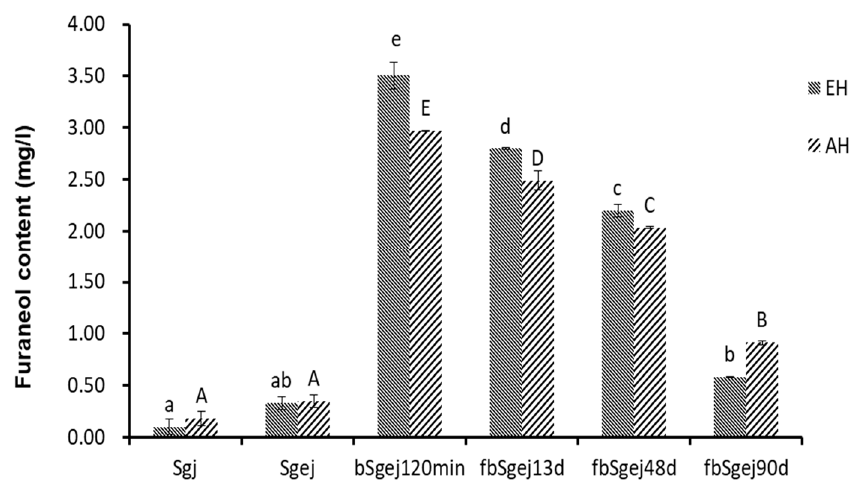
Figure 2. The quantity of furaneol released from furaneol glucosides by enzymatic hydrolysis (EH) (by glycosidase AR 2000, at 40 ° C for 16 h, pH 5.0) and thermal acidic hydrolysis (AH) (100 ° C for 1